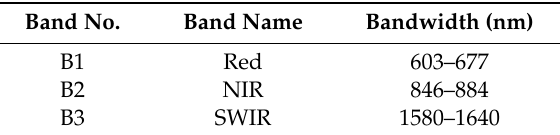
Table 1. VIIRS surface reflectance